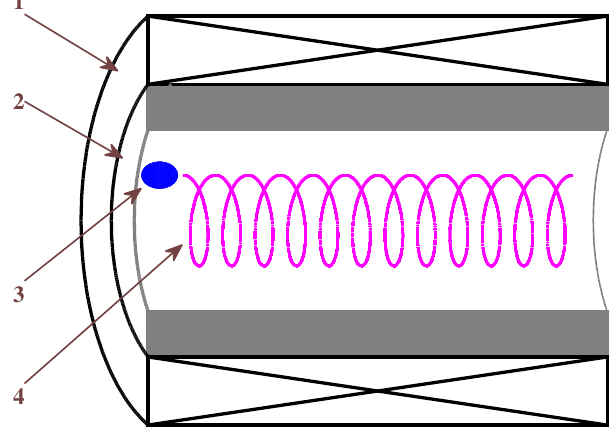
FIG. 1. Scheme of the radiation section: 1 — magnetic system creating a transverse helical undulator and strong uniform longi- tudinal fields; 2 — oversized metal circular waveguide; 3 — electron bunch; 4 — helical stationary electron